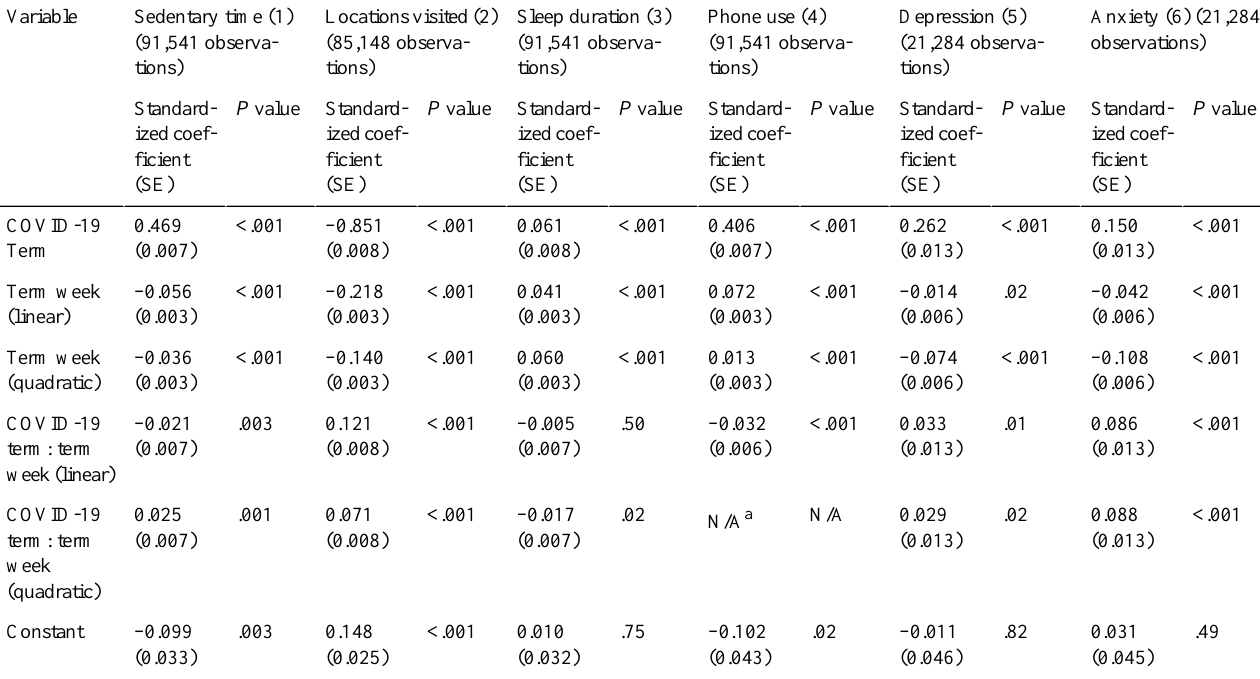
Table 1. Models of sedentary time, locations visited, sleep duration, phone use, depression, and anxiety by week and by presence of COVID-19 during the academic